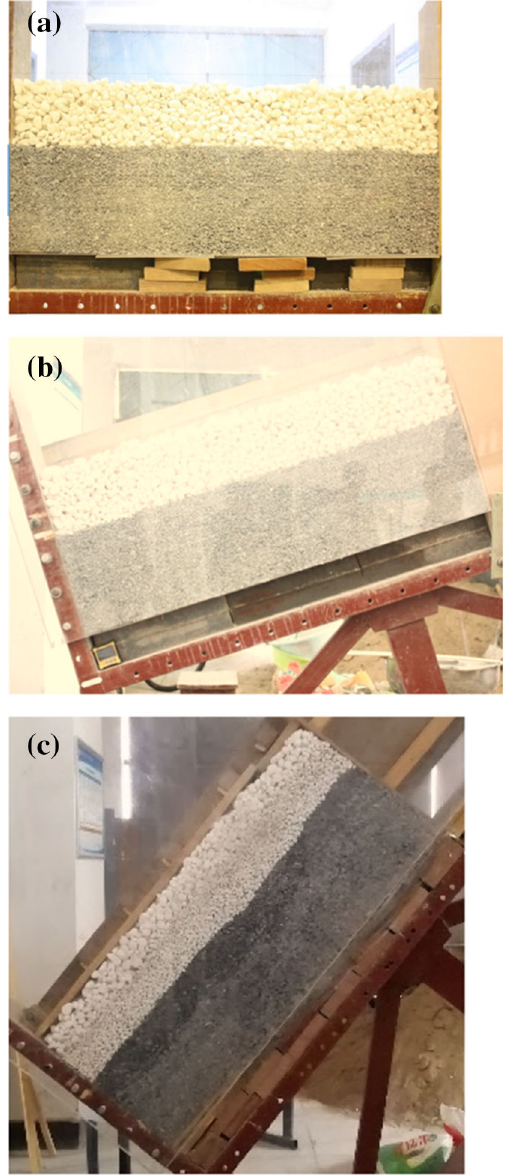
Fig. 2 Three of the experimental models in the initial stage: a a = 0 (cid:3) ; b a = 20 (cid:3) ; c a = 50